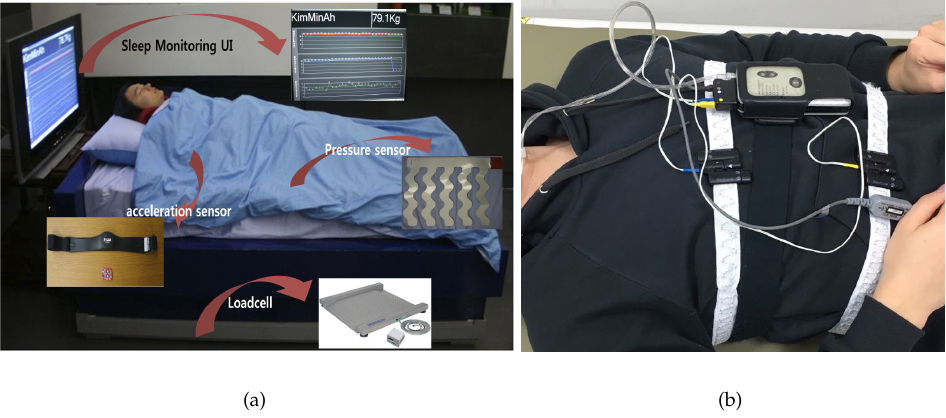
Figure 3. Our test-bed environment, ( a ) test-bed; ( b ) Polysomnography.